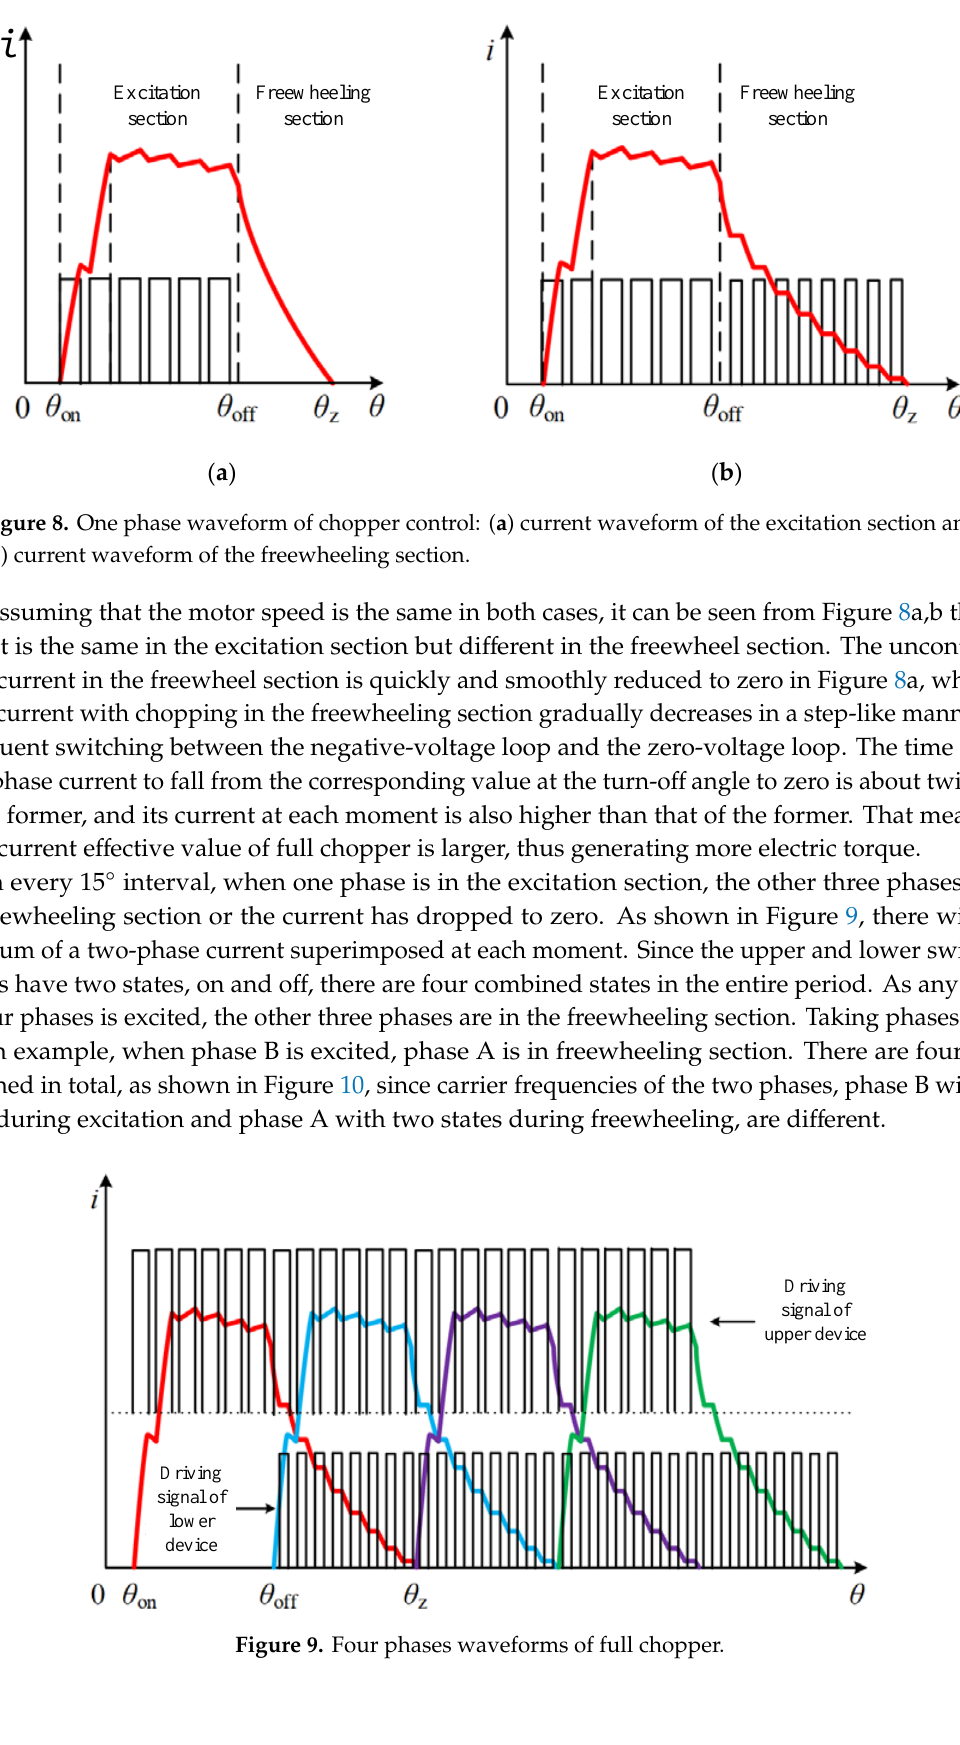
( d ) Figure 10. Four cases of speed regulating system: ( a ) case 1, ( b ) case 2, ( c ) case 3, and ( d ) case 4. Take phase A in the excitation section as an example: Case 1: Phase A is a positive voltage loop, and phases B, C, and D are all negative voltage loops. Therefore, the DC-bus current i o = i A – i B – i C – i D as shown in Figure 10a. Case 2: Phase A is a positive voltage loop, and phases B, C, and D are all zero-voltage loops. Therefore, the DC-bus current i o = i A as shown in Figure 10b. Case 3: Phases A, B, C, and D are all zero-voltage loops. Therefore, the DC-bus current i o = 0 as shown in Figure 10c. Case 4: Phase A is a zero-voltage loop, and phases B, C, and D are all negative voltage loops. Therefore, the DC-bus current i o = – i B – i C – i D as shown in Figure 10d. In the above four cases, the DC-bus current of case 2 and case 4 are positive and negative, respectively. The DC-bus current of case 3 gradually increases from a negative value, for which the